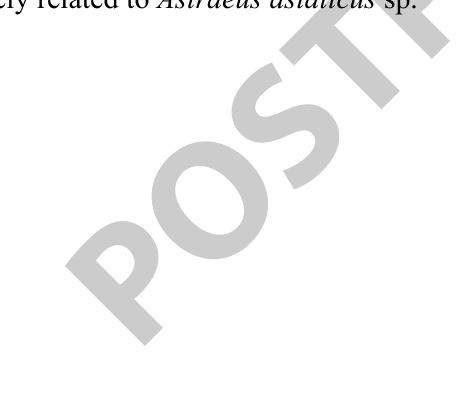
Figure 6 Neighbor-joining phylogenetic tree showing the evolutionary relationship of the ITS gene sequences. The tree was constructed based on evolutionary distances, which revealed that the test organism is closely related to Astraeus asiaticus